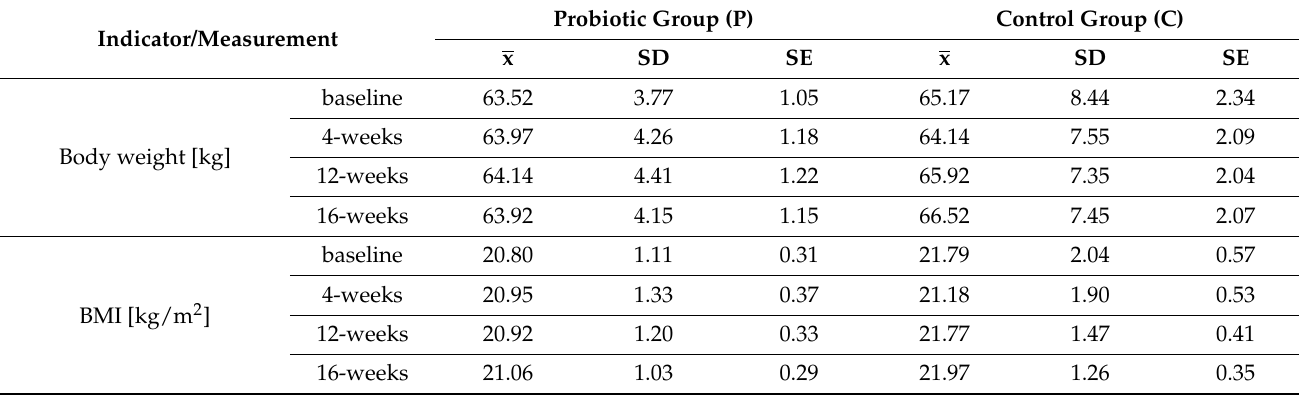
Table 6. Body weight, BMI, fat-free mass (FFM), fat mass (FM), and muscle mass (MM) at follow-up measurements during supplementation